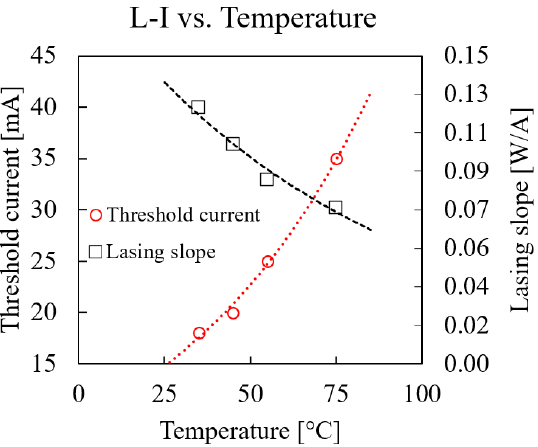
Figure 3. Laser L–I temperature dependence: lasing slope (black) and threshold current (red).